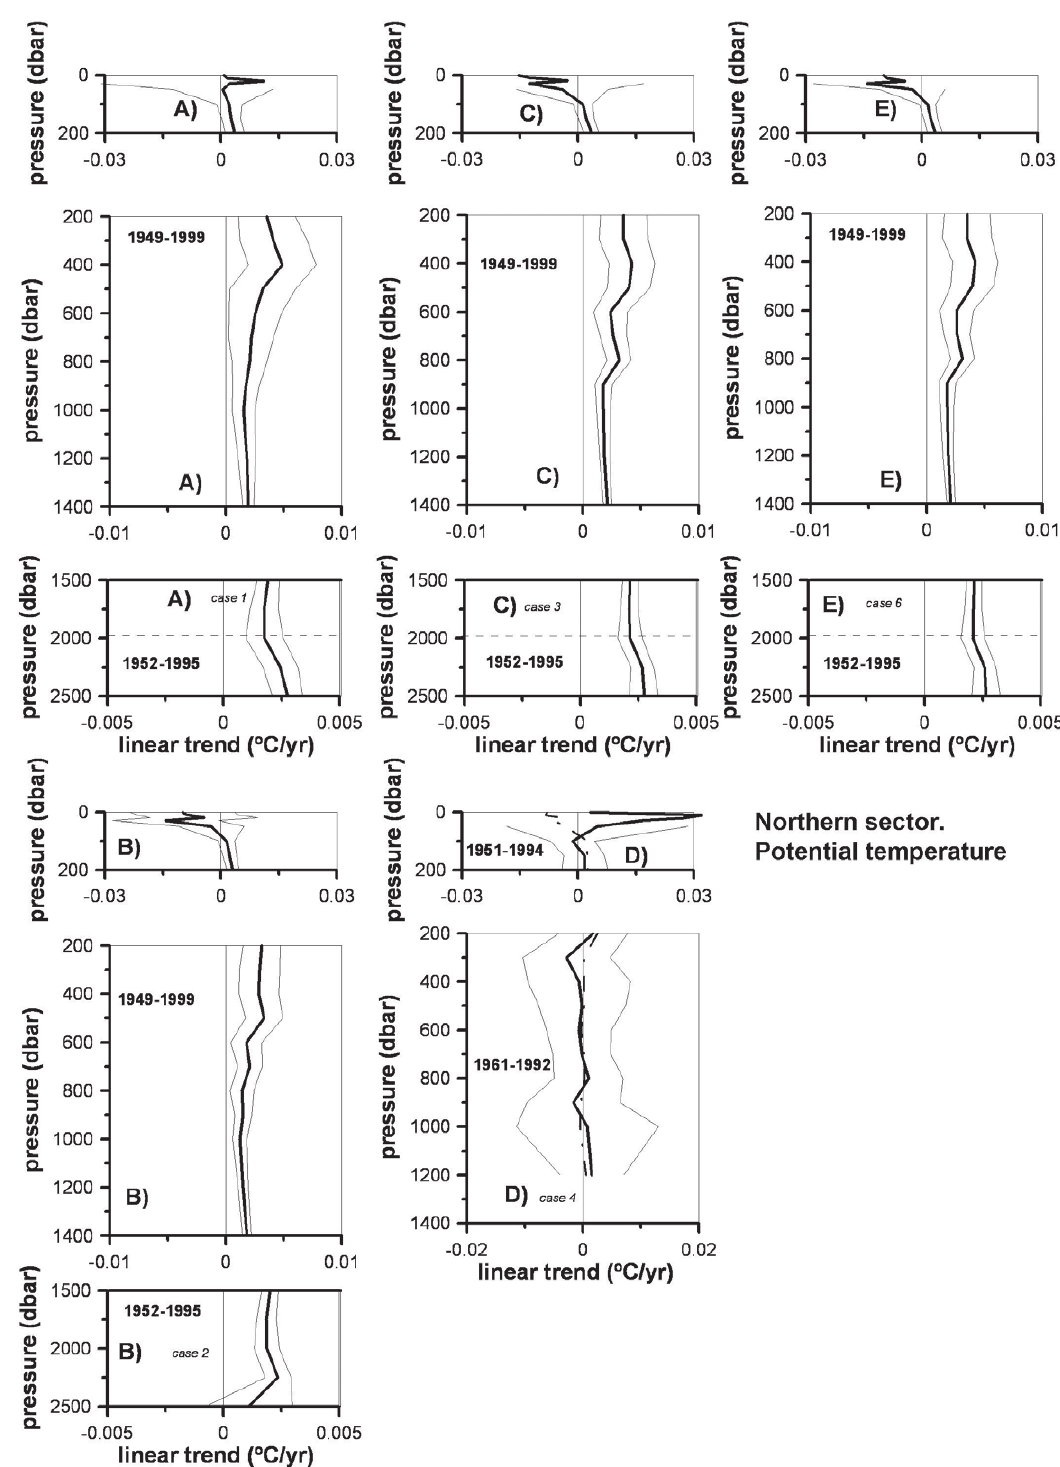
Fig . 10. – as in Figure 6, but for the northern